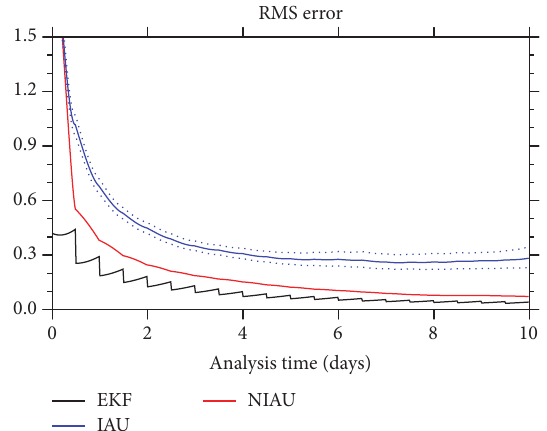
Figure 3: Variable-averaged RMS error (RMSE) obtained from the EKF (black line), the IAU (blue line), and the NIAU methods (red line). Note that a 12-hour assimilation interval is applied, and the dotted line denotes the 95% confidence level of the IAU using a bootstrap